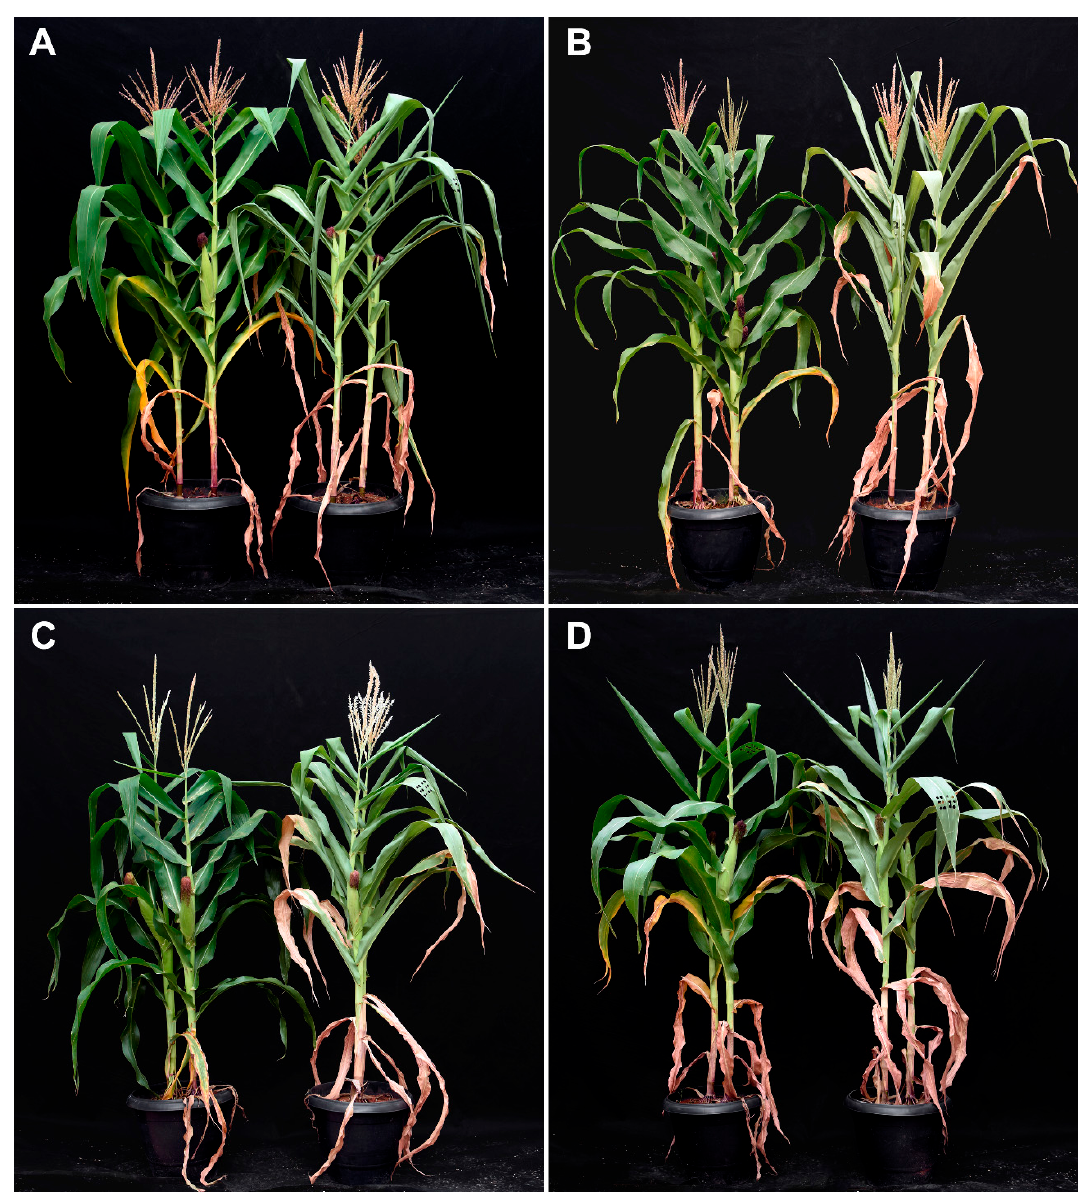
Figure 8. Drought effects on leaf characteristics and canopy architecture of maize plants. ( A ) BRS 1030, ( B ) BRS 1010, ( C ) 2B 707, ( D ) DKB 390. Plants on the left hand side were grown in soil at field capacity (control), while those on the right hand side were subjected to soil water shortage (drought) for 12 consecutive days at pre-flowering stage. Images were taken on the 12 th day under drought.